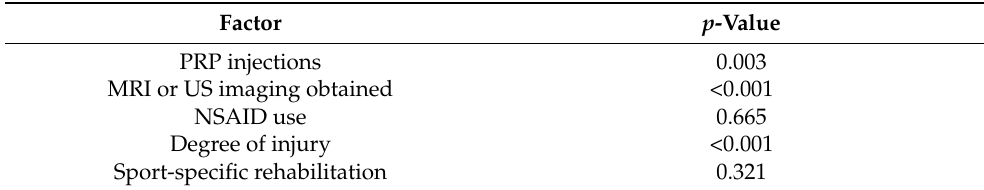
Table 1. The association between various factors and the duration of treatment (Mann–Whitney test for two categories; Kruskal–Wallace test for several